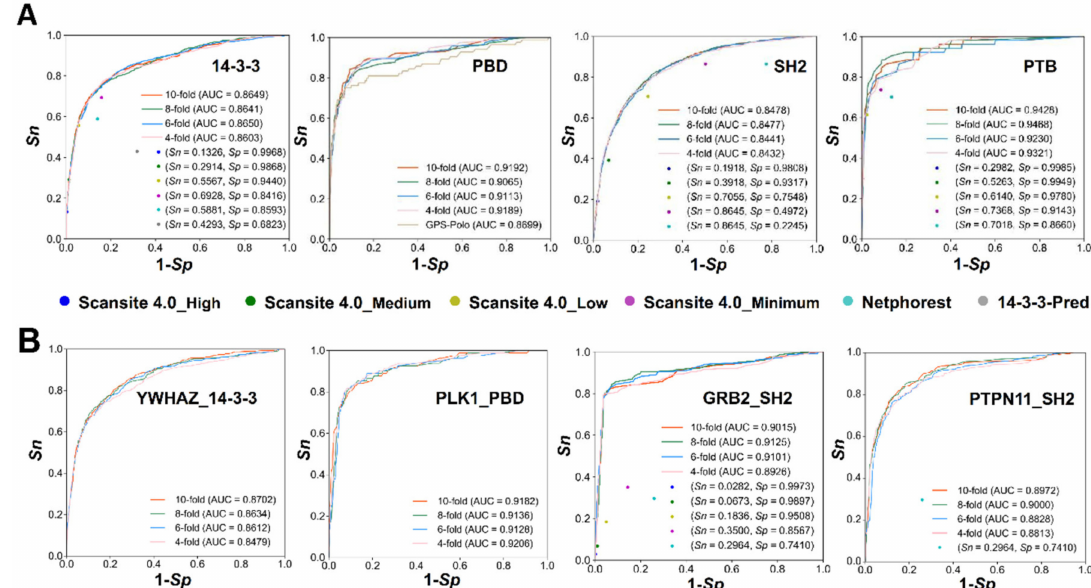
Figure 4. Comparison of GPS-PBS with other existing tools, including Scansite 4.0 [23], NetPhorest [20], 14-3-3-Pred [27], and GPS-Polo 1.0 [25] at ( A ) the family level, and ( B ) the single PPBD cluster